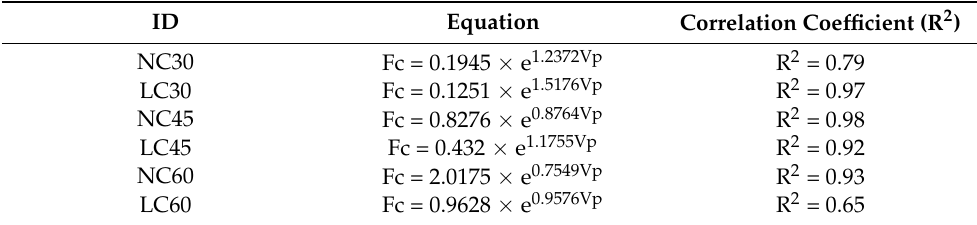
Table 7. Correlation between the compressive strength and the ultrasonic pulse